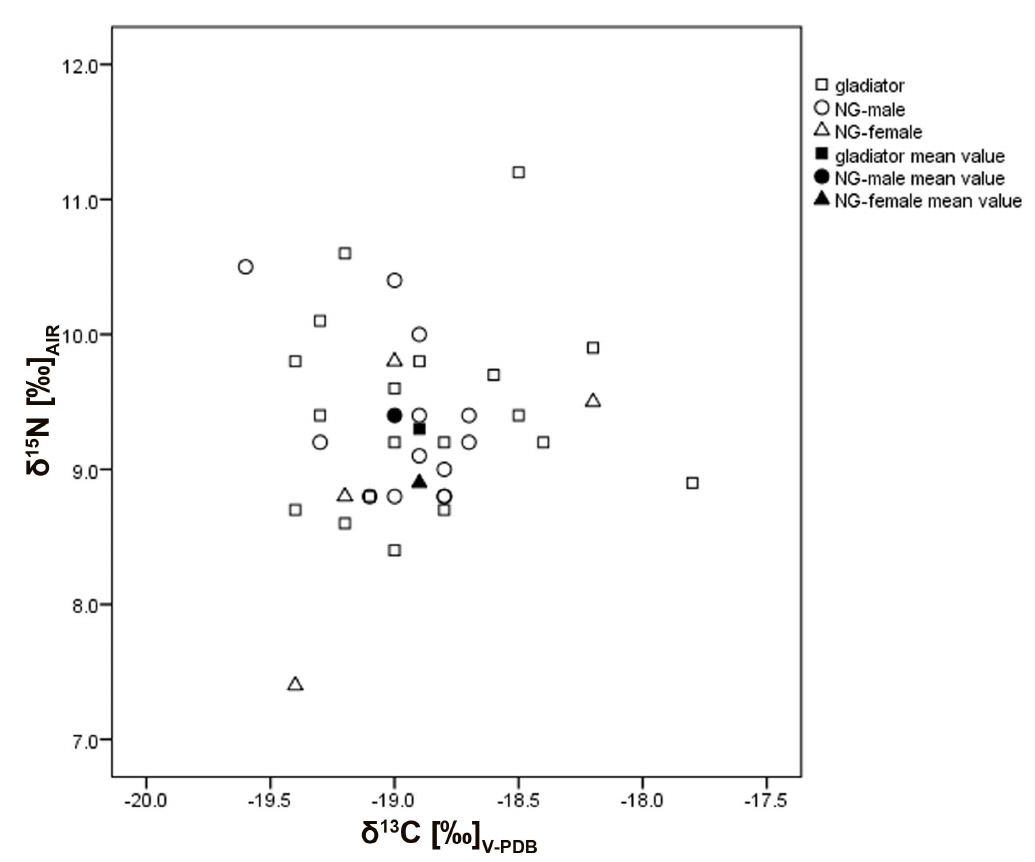
Figure 3. Stable d 13 C and d 15 N ratios. Comparison between different groups (gladiators, NG-males, and NG-females).